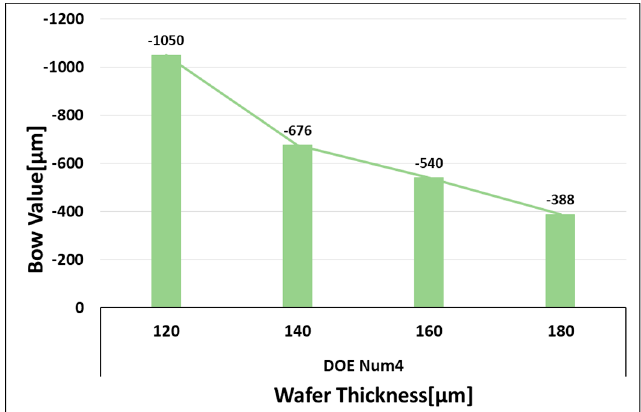
Figure 12. Influence of the front-side electrode on bow phenomenon according to thickness of c-Si wafers.